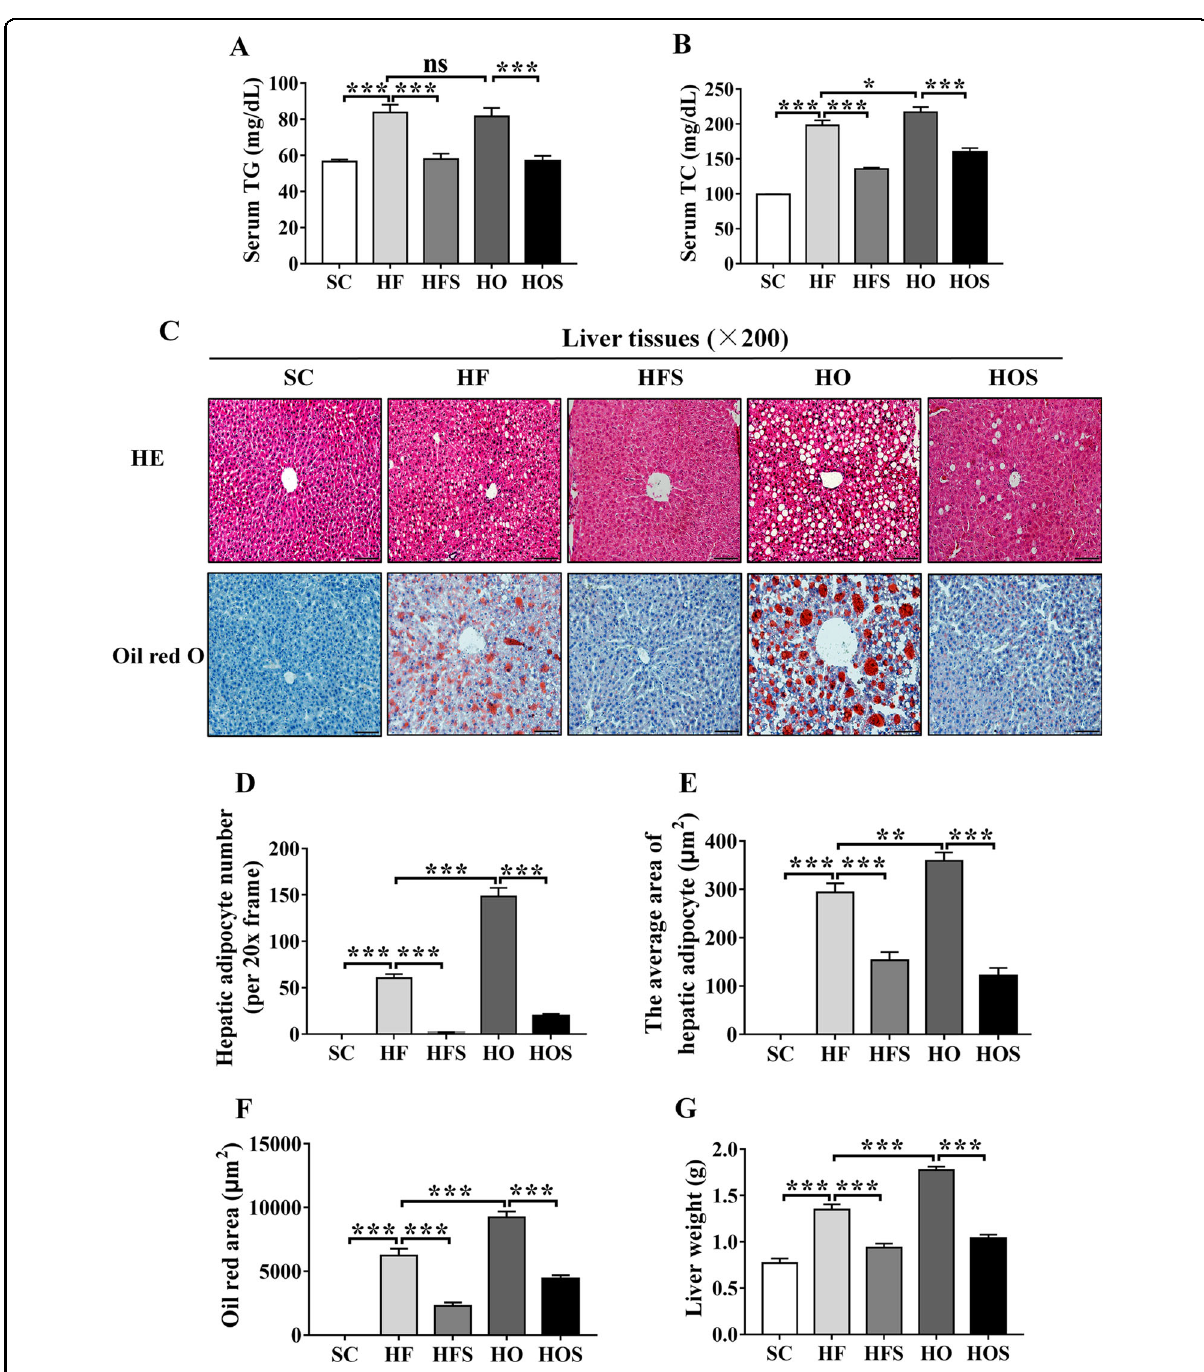
Fig. 3 Salubrinal improved obesity-induced hepatic steatosis. a Serum triglyceride level. b Serum total cholesterol level. c Representative H&E and oil red O staining images showing salubrinal effect in hepatic steatosis (200×; scale bar = 100 μ m; all graphics were in a blinded fashion). d The number of hepatic adipocytes. e The average area of hepatic adipocyte. f Oil red area. g Liver weight. The asterisks (*, **, and ***) represent P < 0.05, P < 0.01, and P < 0.001, respectively. N.s., not signi fi